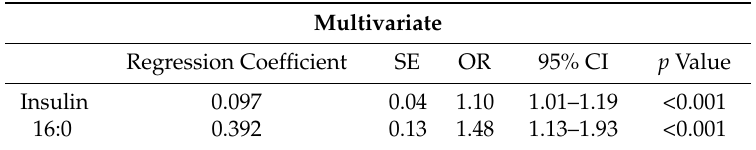
Table 5. Independent predictors of liver